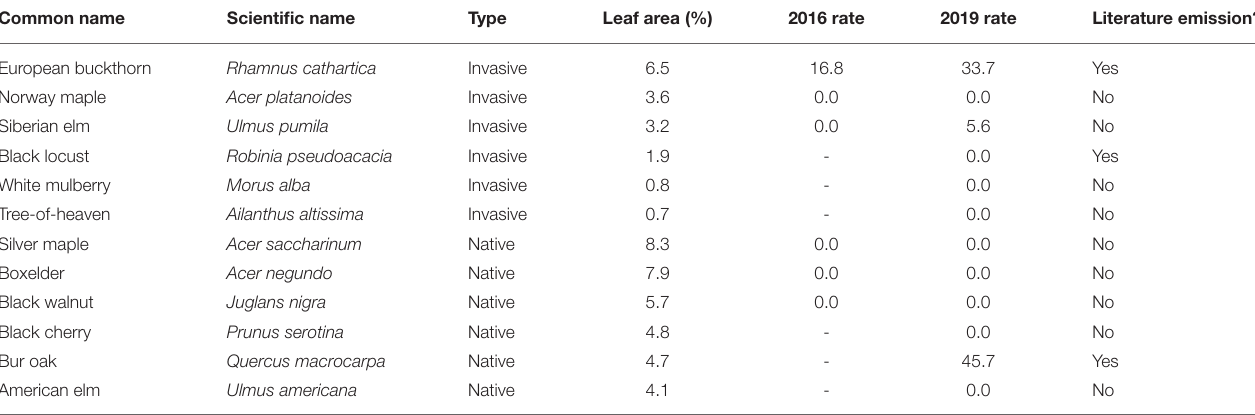
TABLE 1 | The type (Invasive or Native), the percent of total regional leaf area [derived from Nowak et al. (2013)], the mean of the measured isoprene emission rate (nmol m − 2 s − 1 , n = 2 for 2016 and n = 3 for 2019) and the reported presence of isoprene emission from the literature (see text for details) for the tree species used in the